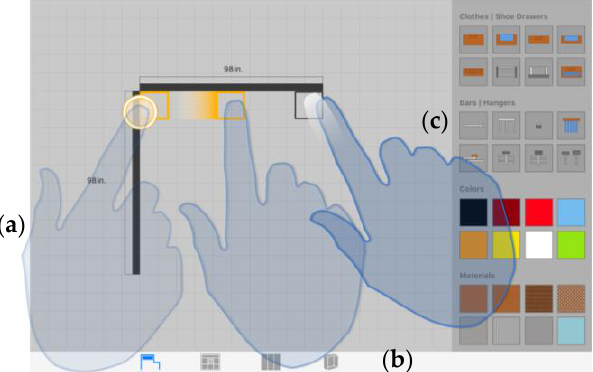
Figure 8. Translation of an object across the canvas: ( a ) single-tap-based object selection, ( b ) single-finger-drag-based object translation, and ( c ) finger-lift-based target object location confirmation.